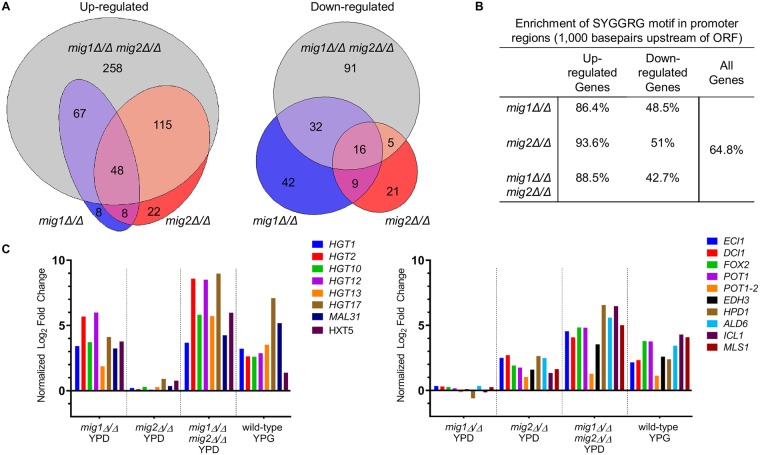
Mig1/2 regulatory effects.A. Venn diagram of genes regulated by Mig1, Mig2, or Mig1 and Mig2. Genes included in the diagram were significantly up- or down-regulated (p<0.05) by at least 2-fold compared to the wild-type strain (CW542) in YPD medium. B. Enrichment of SYGGRG motif in Mig1/2 target gene promoters. Promoter sequence was defined as 1,000 basepairs upstream of the open reading frame of up- or down-regulated genes. C. Fold change expression of chosen Mig1 and Mig2 selective genes compared to the wild-type strain analyzed by RNA-Seq and compared between datasets. Mig1 selective genes were significantly up-regulated in the mig1Δ/Δ and mig1Δ/Δ mig2Δ/Δ, but not the mig2Δ/Δ strain profiles. Mig2 selective genes were significantly up-regulated in the mig2Δ/Δ and mig1Δ/Δ mig2Δ/Δ, but not the mig1Δ/Δ strain profiles.